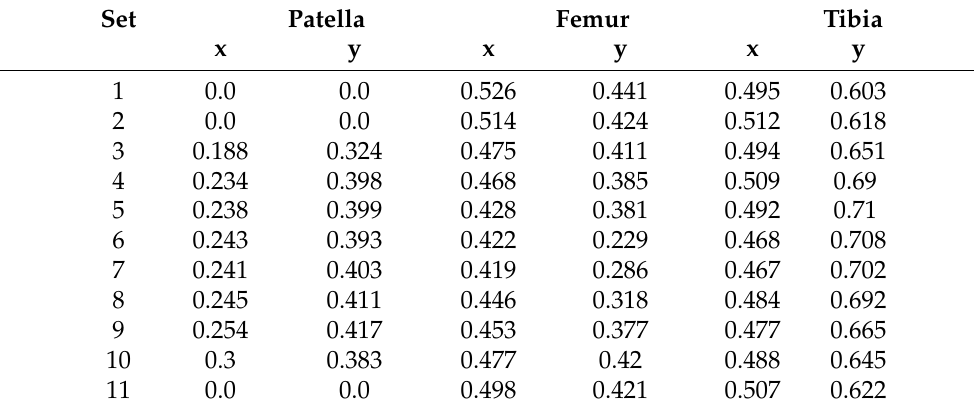
Table 2. Normalized values of the x and y coordinates of the centroid due to the size of the slice on the sagittal